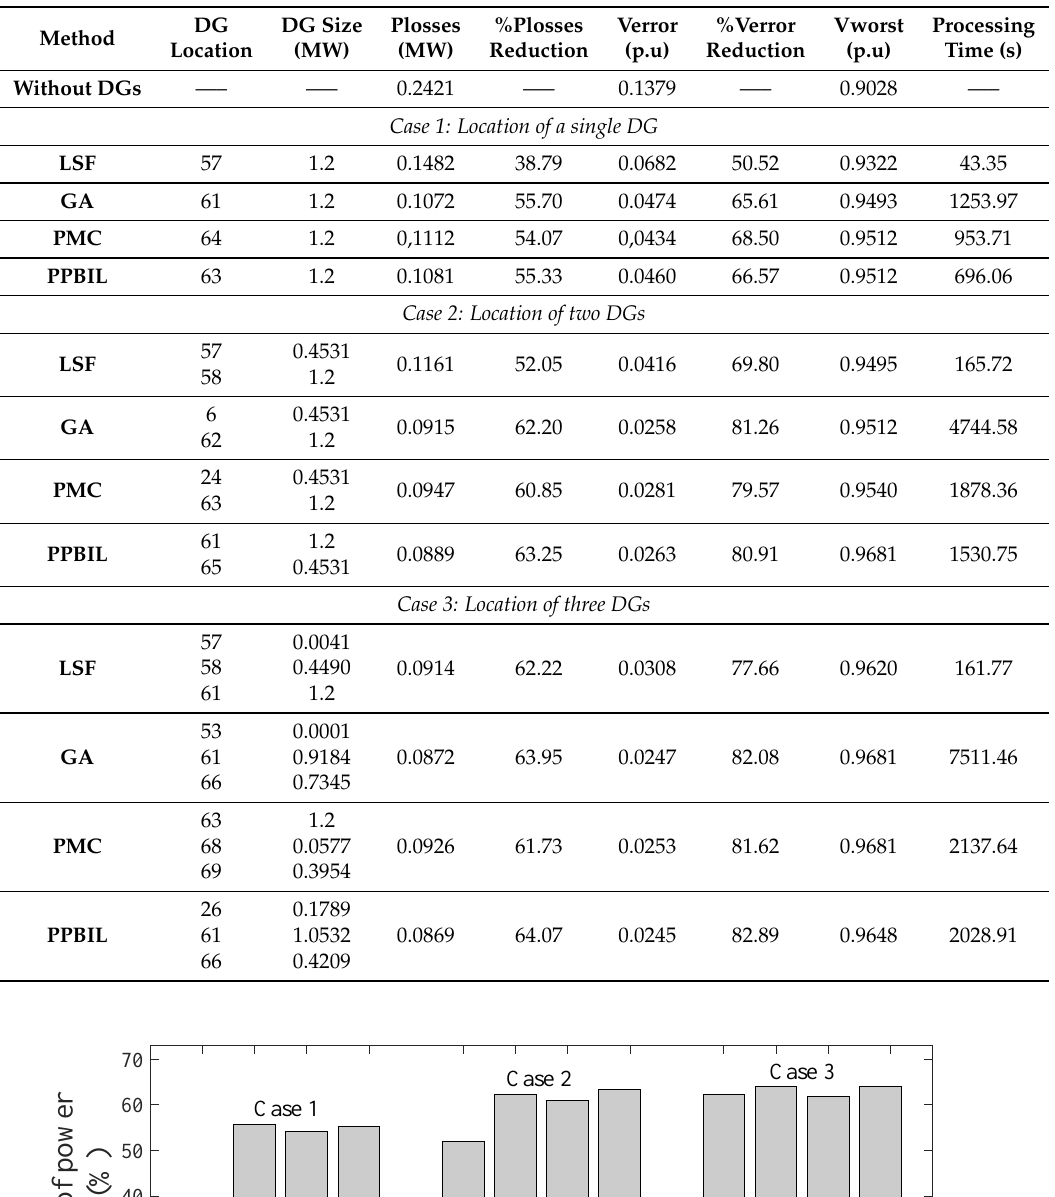
Table 4. Results of optimal location and sizing of DGs for the test system with 69 buses.